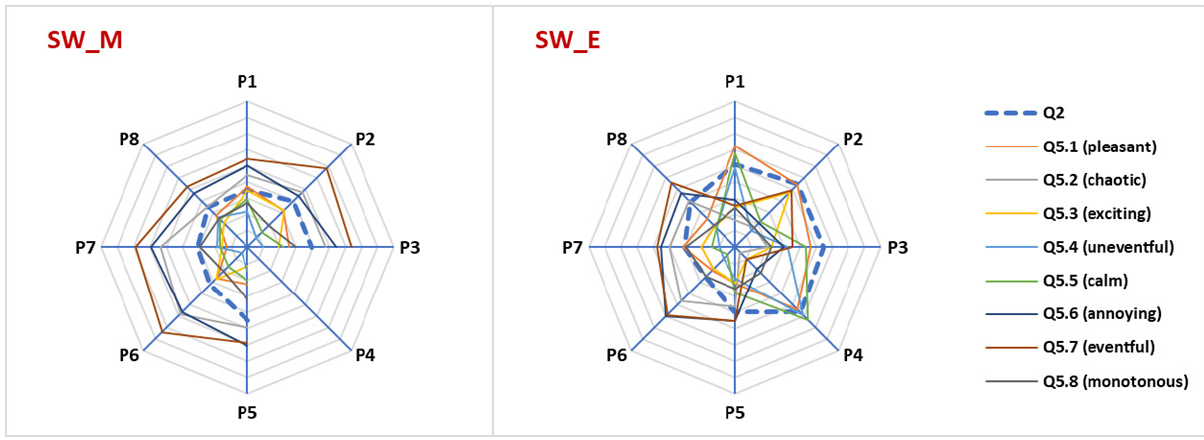
Figure 18: Mean overall appraisal (Q2 answers) together with mean Q5 answers at every soundwalk stop [P1 to P8] during SW_M (left; no data at P4) and SW_E (right)